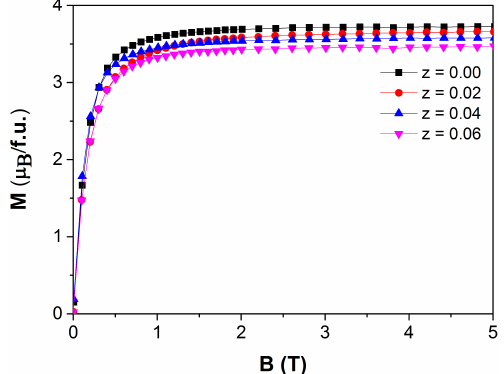
Figure 6. Field dependence of the magnetization of Mn 1.00 Fe 0.85 Co 0.10 P 0.55 − z Si 0.45 B z compounds measured at a temperature of 5